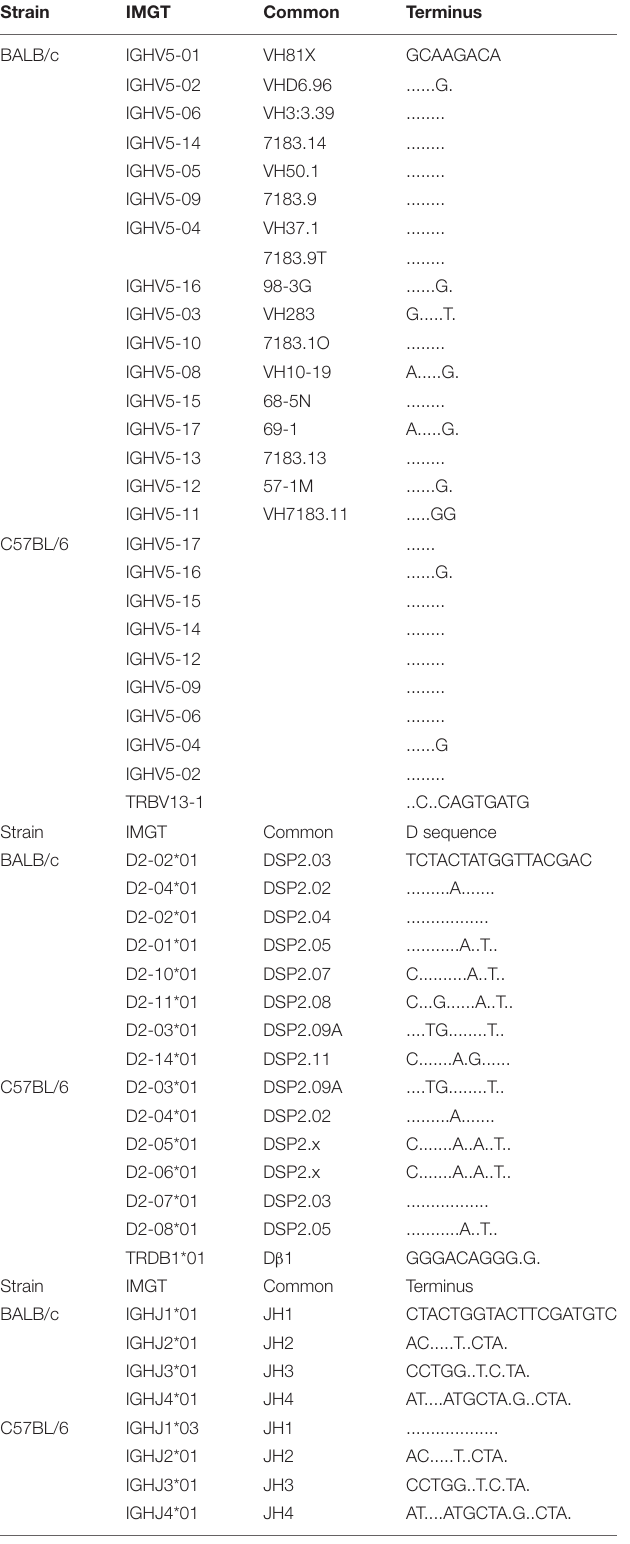
TABLE 1 | Continued Strain IMGT Common